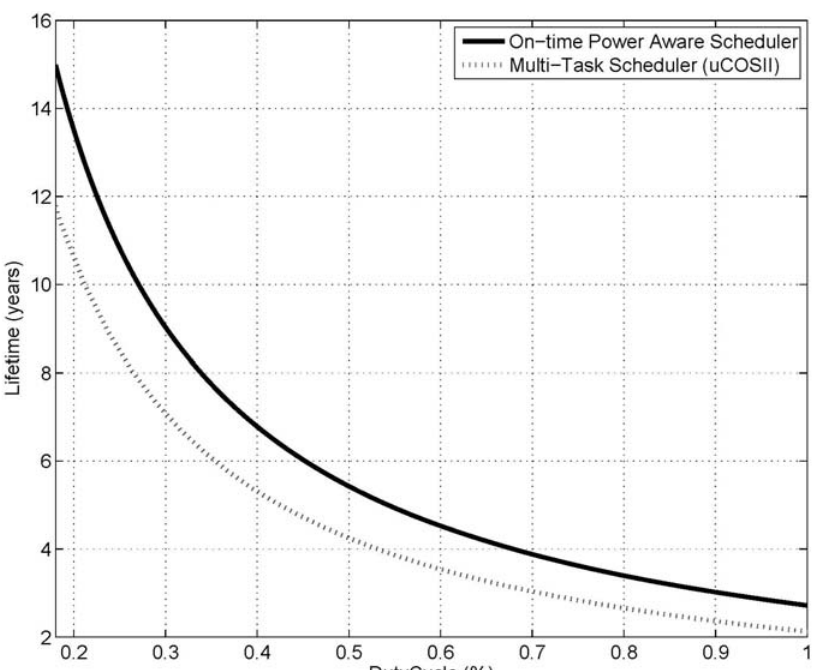
Figure 13. Comparison of lifetimes of the two